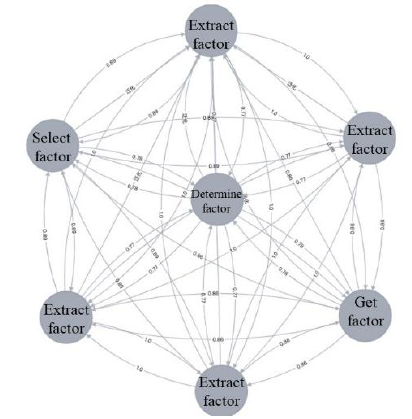
Figure 9 . Event node generalization.